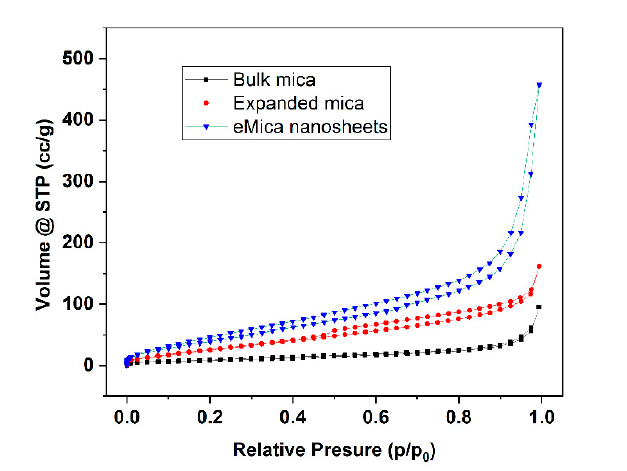
Figure 4. N 2 Adsorption/desorption isotherms of bulk mica, expanded mica and eMica nanosheets at 77 K.